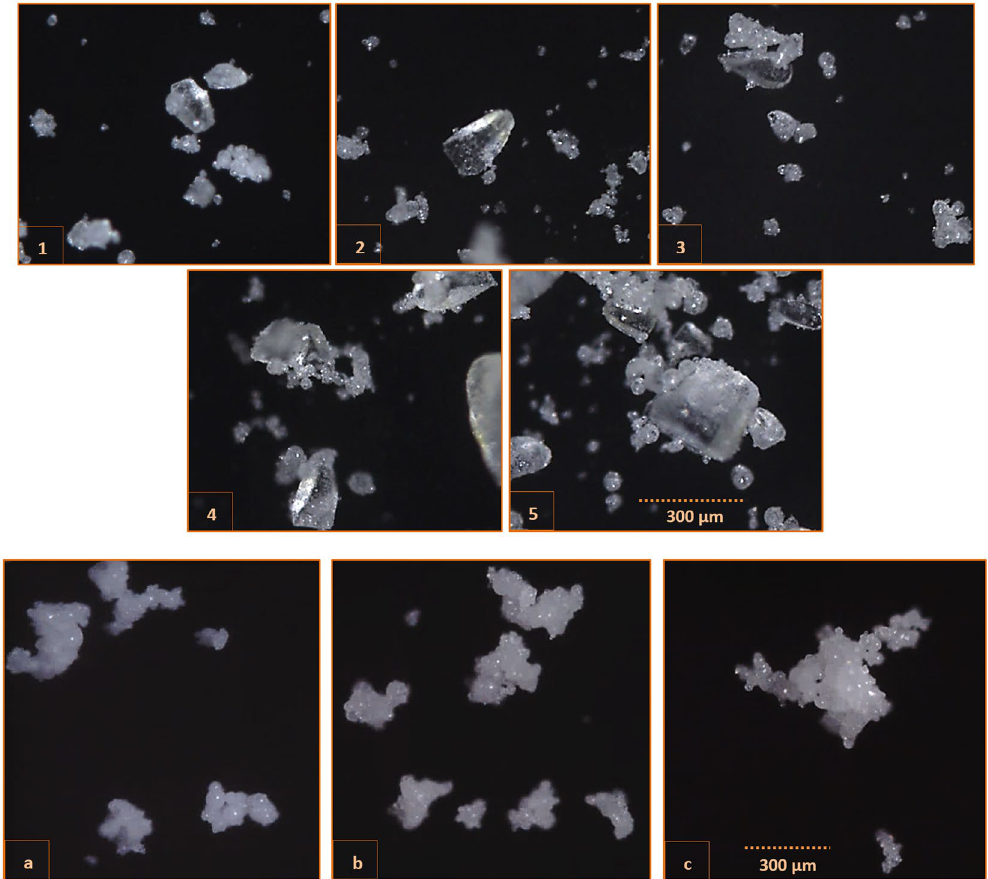
Figure 6. High speed imaging of milk derivative product particles. 1–5: Samples of acid whey powder with poor solubility. a – c Samples of fat filled milk. Images were taken on a moving sample holder using the setup in Fig. 1, left, with pulsed white light allowing real time monitoring. Image processing results and statistics of particle size-shape distributions are shown in Table